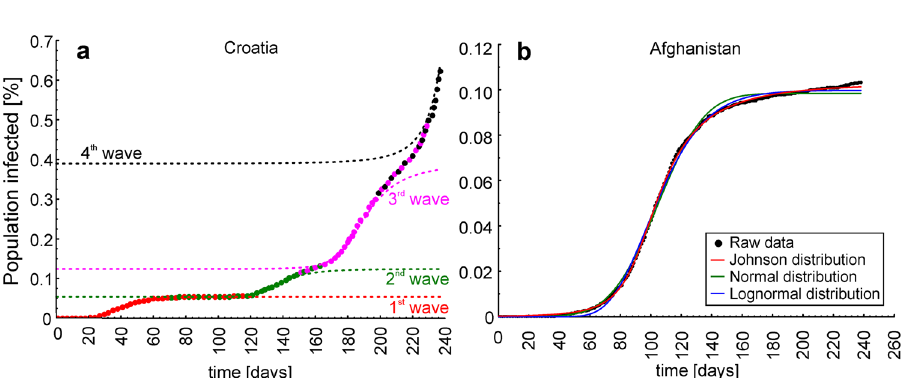
Figure 2. Examples of Johnson cumulative density functions fitted to the cumulative epidemic curves in four scenarios of COVID-19 infection dynamics. ( a ) One ongoing infection wave (before the peak), ( b ) one full wave, ( c ) two waves and ( d ) four overlapping and interfering waves. Open circles—raw data, red lines—fitted Johnson CDFs.